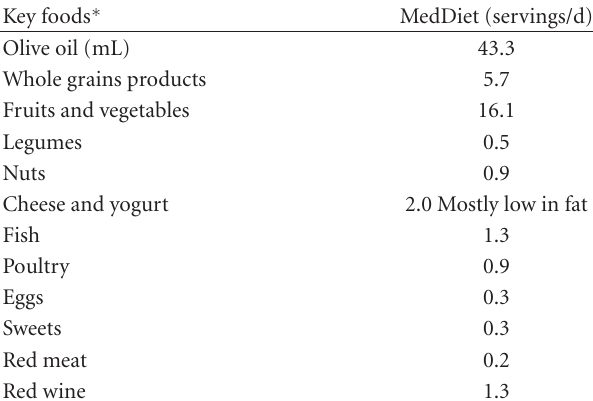
Table 1: Servings of key foods of the Mediterranean pyramid consumed daily during the Mediterranean diet intervention for a 10460 kJ/d (2500kcal/d)